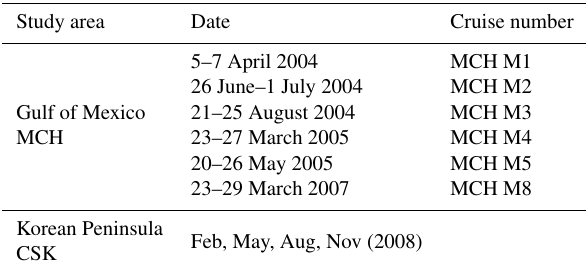
Table 1. Sampling dates for data from Gulf of Mexico projects and the coastal sea of the Korean Peninsula. Winter data are listed for the Gulf of Mexico